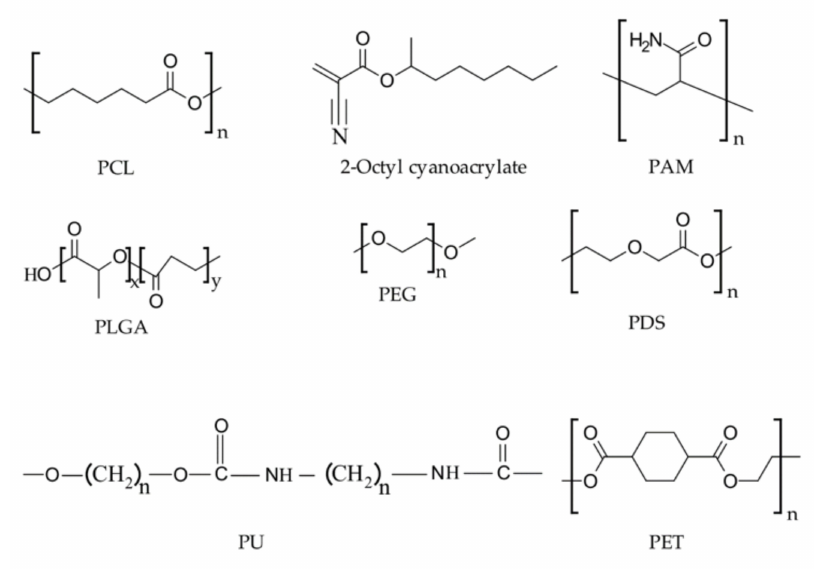
Figure 3. Representative chemical structures of synthetic hemostatic